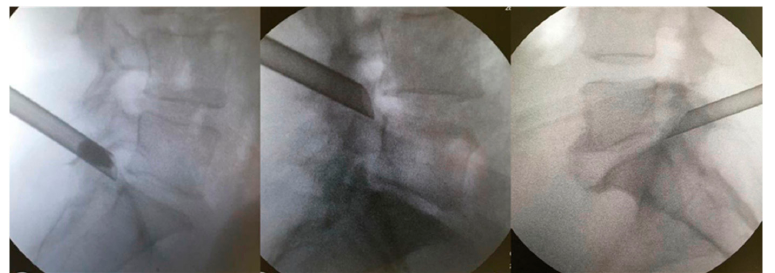
Figure 2. Extraforaminal position of the working cannula before foraminoplasty is supported by the caudal vertebra’s